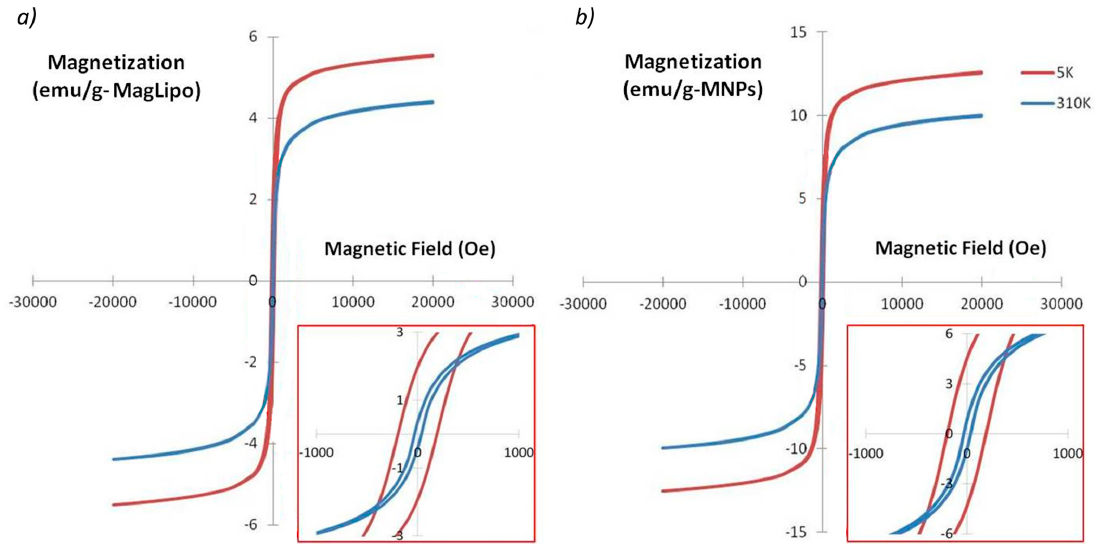
Figure 4. Magnetic characterization of MagLipo ( a ) and of MagNPs ( b ). Hysteresis curves acquired at 5 K and 310 K. In the inset enlargement of the plot showing hysteresis process.